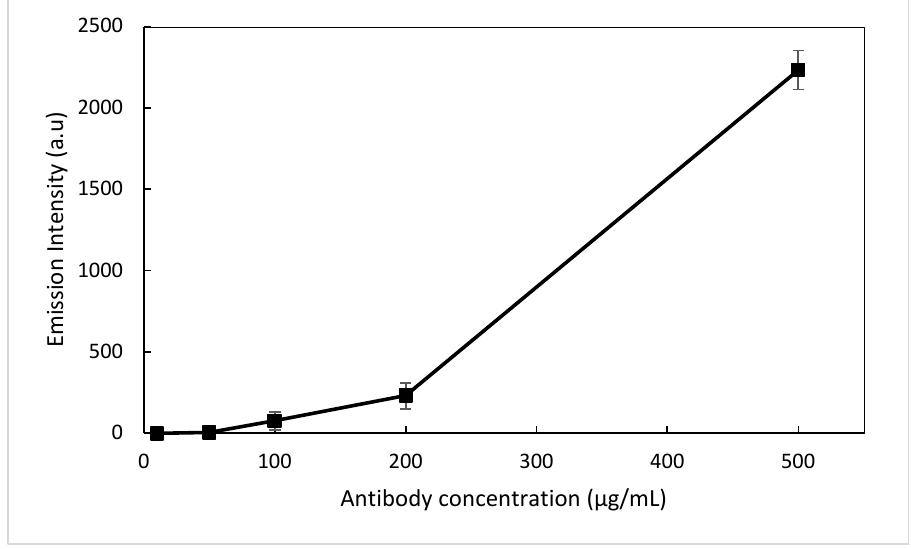
Figure 10. Antibody concentration curve @ 574 nm.